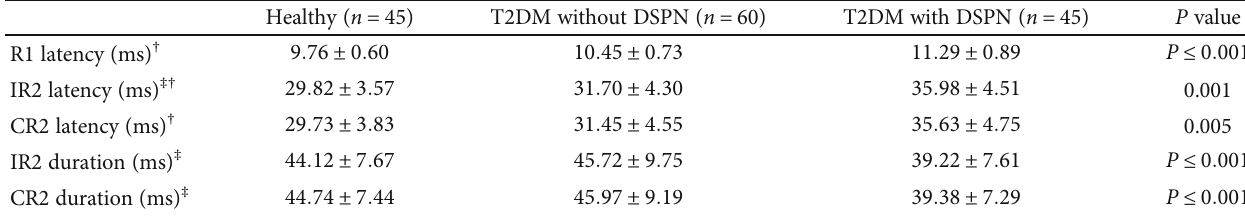
Table 4: Di ff erences in blink re fl ex among the normal, T2DM without DSPN, and T2DM with DSPN groups. Healthy ( n = 45 ) T2DM without DSPN ( n = 60 )